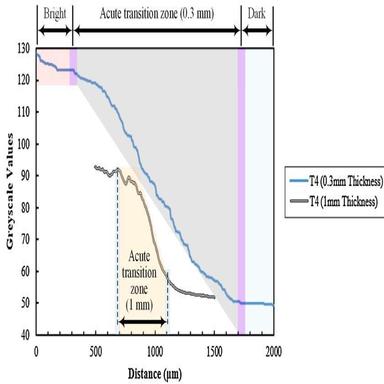
Comparison between greyscale values of samples from same region (T4) with thickness of 0.3 mm and 2 mm to represent the gradient particle distribution at T4.